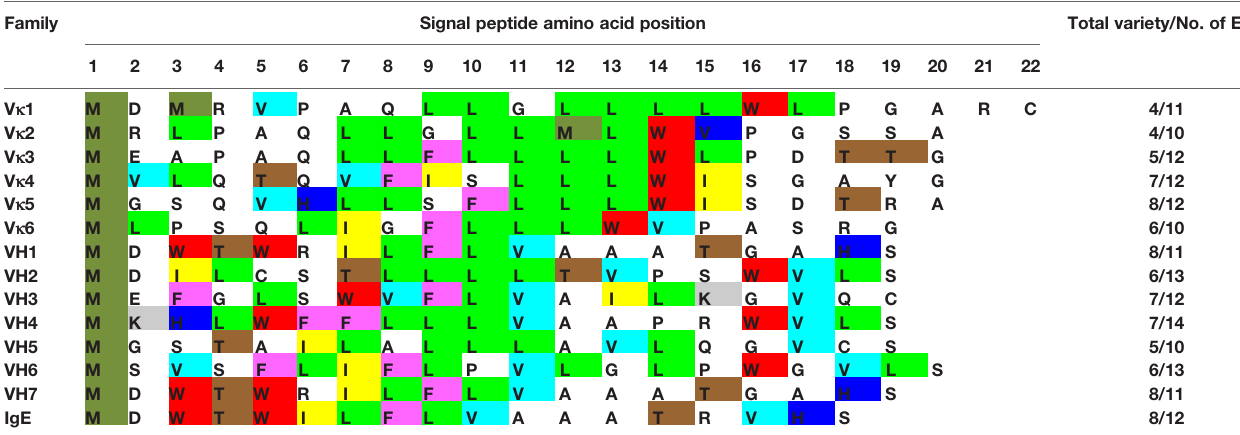
( Figure8 )andF1-score0.62 – 0.7(ofwhich1re fl ectingthebestbalance